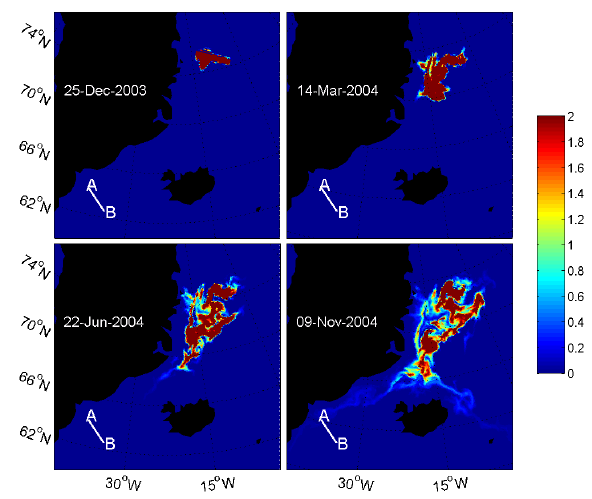
Fig. 13. The mean OCCAM January 2004 27.7 isopycnal coloured by salinity, showing water displaying the same salinity properties as Arctic Atlantic Water (34.45–34.9; Rudels et al., 2002) present along the east coast of Greenland.